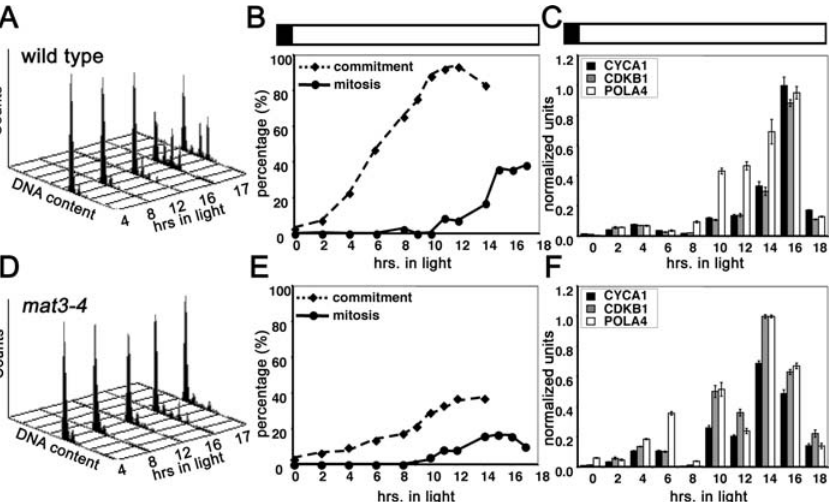
Figure 8. Cell Cycle Kinetics and Gene Expression in Partially Synchronized Cultures of Wild-Type and mat3–4 The light/dark phase is indicated by white or dark bars above the graphs. (A, D) FACS profile showing the DNA content of wild-type and mat3–4 strains that were dark shifted and returned to continuous light. (B, E) Graphs show Commitment (black diamonds with dashed lines) and mitotic index (black circles with solid lines) of the cultures. Both wild-type and mat3–4 cultures entered S/M phase at approximately 8 to 10 h after return to the light and reached a mitotic peak at approximately 14 to 16 h. (C, F) Expression of S/M phase markers CYCA1 , CDKB1, and POLA4 by quantitative RT-PCR as described in Figure 7. DOI: